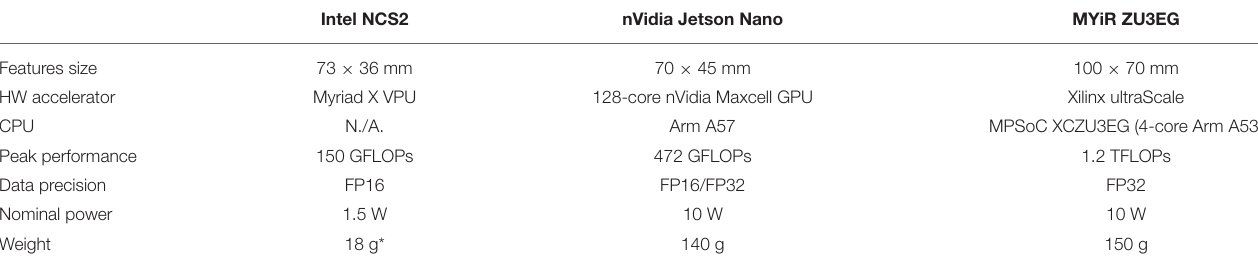
TABLE 1 | Main specifications of the candidate platforms in this